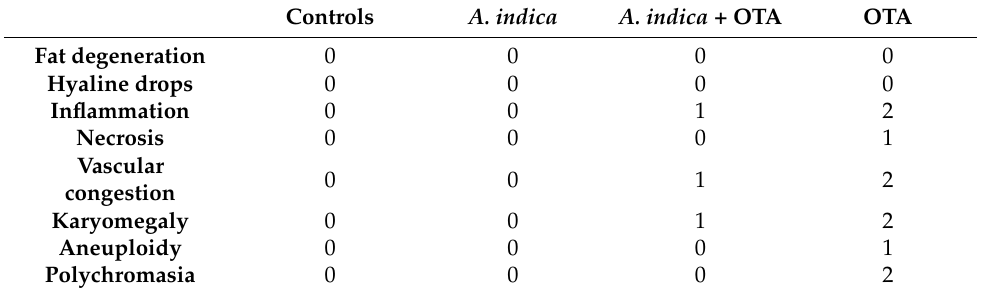
Table 2. Comparative pathomorphological changes in four groups: control-non-treated mice; A. indica oil-mice are protected only with oil; the group with combined therapy A. indica + OTA; a group treated only with OTA. Legend: 0—No changes; 1—Weak changes; 2—Moderate changes; 3—Strong changes.